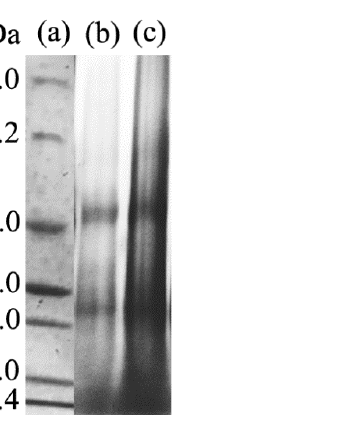
Figure 4. Raman spectra of wool fibers and regenerated keratin samples. The Raman spectra of wool fibers and regenerated keratin films are shown in Figure 4. According to the literature [25,26], disulfide bonds of different conformations form absorption peaks at different positions in Raman spectra. The disulfide bond of gauche-gauche conformation was located at 510 cm −1 , gauche-trans at 520 cm −1 , and trans-trans at 540 cm −1 . It can be seen from Figure 4 that the absorption peak formed by the disulfide bonds in the wool fiber was located at 513.9 cm −1 ; however, the absorption peak in KF was blue-shifted (shift to higher frequencies) to 547.1 cm −1 . This change indicated that during the dissolving and extracting process of regenerated keratin, the disulfide bonds in the fibers were disrupted and a random reconstruction occurred, leading to a transformation of disulfide bond conformation. Except for the change of the disulfide bonds, the Raman spectrum of the KF sample was generally the same as that of wool fibers, and the main Raman characteristic peaks of wool fibers were shown in Table 1 [27]. This phenomenon indicated that the regenerated keratin still retains the basic chemical properties of the protein.